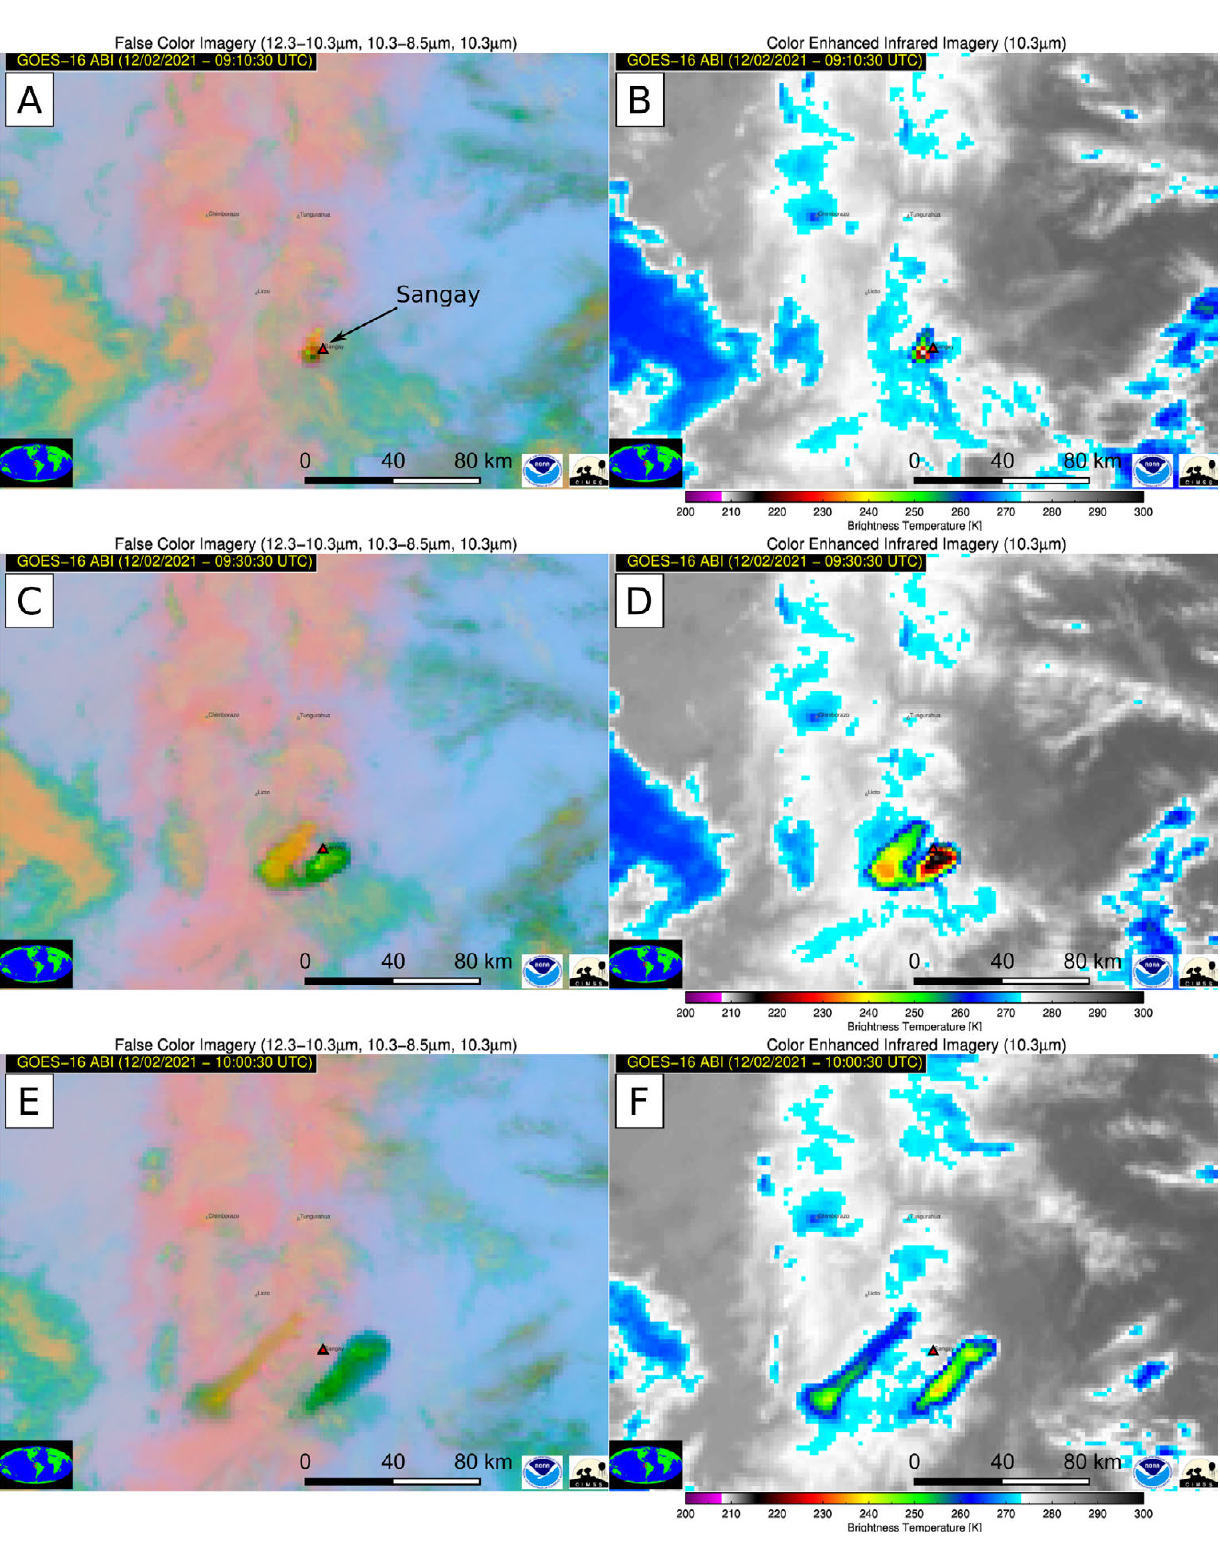
Figure 12: GOES-16 False Color and Color Enhanced Infrared Imagery of the volcanic clouds (Source: Volcanic Cloud Monitoring). [A] and [B] 09:10 UTC: initial explosion. [C] and [D] 09:30 UTC: division between a high cloud directed toward the east and a lower cloud directed toward the west-southwest. [E] and [F] 10:00 UTC: no further alimentation of the volcanic clouds is